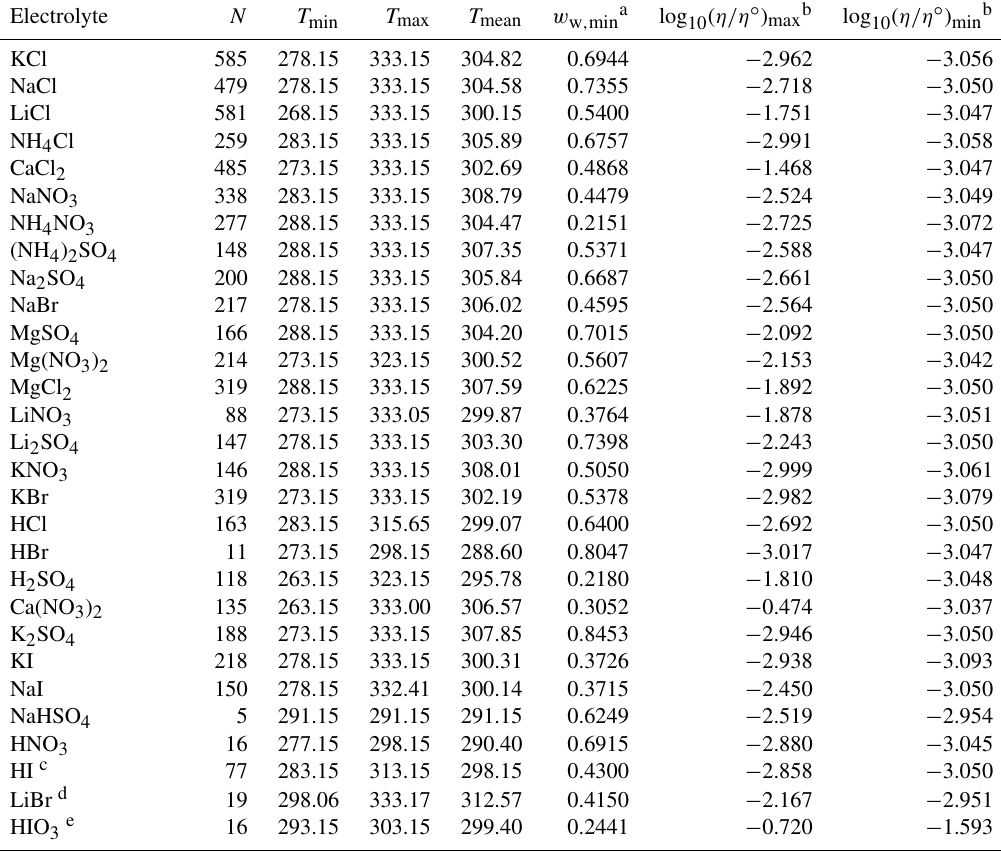
Table 2. Data set information for bulk measurements of binary aqueous electrolyte solutions used to fit the AIOMFAC-VISC electrolyte model. All data have been aggregated by Laliberté (2007, 2009) unless otherwise noted.